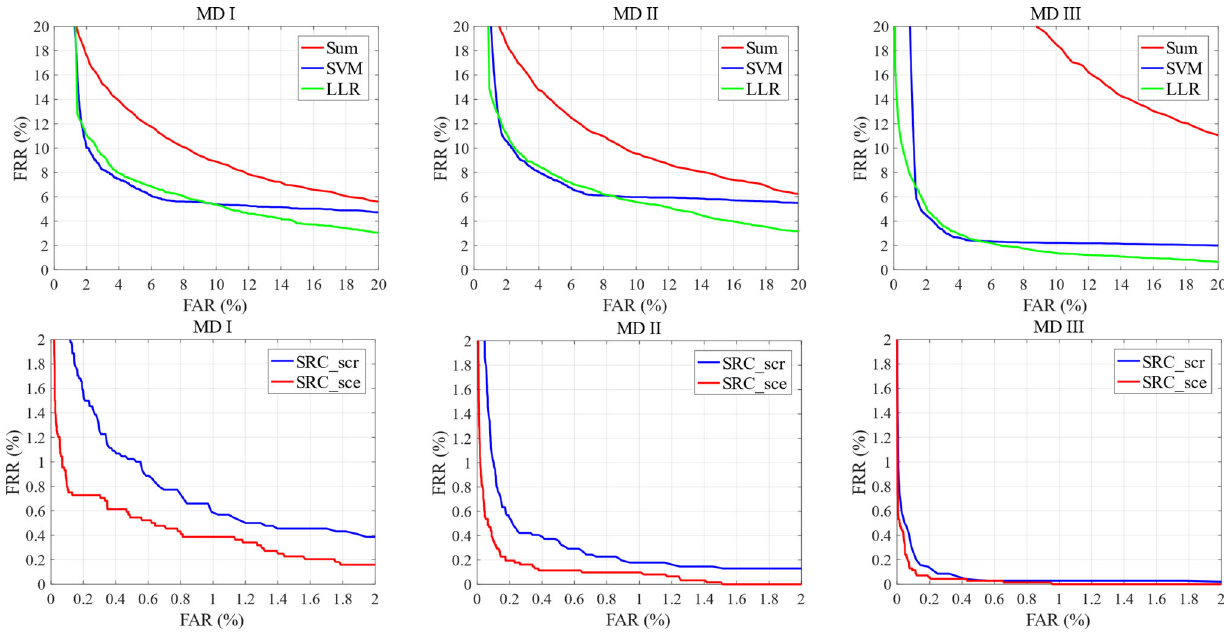
Fig. 11 ROC curves of all the multimodal methods using DCT features on MD I, MD II, and MD III